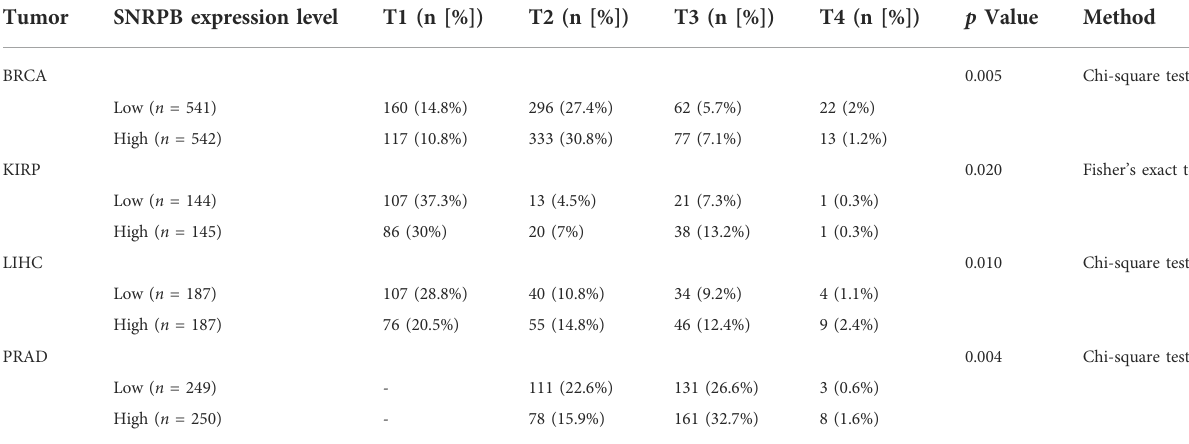
TABLE 1 The relationship between SNRPB expression and tumor T stages.